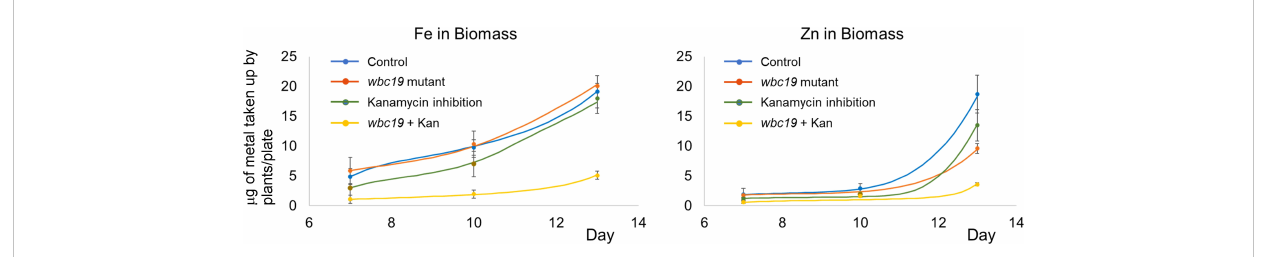
FIGURE 2 Time courses of total iron and zinc content of control and wbc19 seedlings grown on MS medium with or without 50mg/l of Kan. The dots and error bars represent the experimental measurements, averaged from three replicates, and their standard deviations. The lines show model